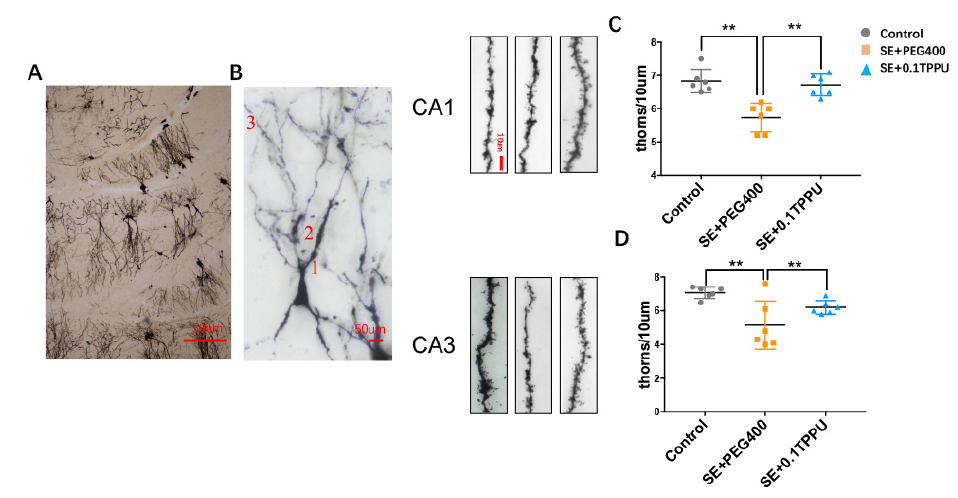
Figure 7. ( A , B ) The dendritic spines density of the third branch ( × 20 magnification in Figure 6A, × 40 magnification in Figure 6B) in the hippocampus. ( C , D ) The number of dendritic spines every 10 µ m length of the third branch ( × 60 magnification) was significantly decreased selectively in the CA1 and CA3 subareas of hippocampus in the SE+PEG400 group compared with the Control group. TPPU pre-treatment significantly recovered the dendritic spines density in the SE+0.1TPPU group compared with the SE+PEG400 group. (Figure 7A,B, one-way ANOVA test, n = 4 in every group, ** p < 0.01. CA, Cornu Ammonis.CA1, CA3: The third branch of dendritic spines in the pyramidal neurons of CA1 and CA3 subareas were photographed and analysed.